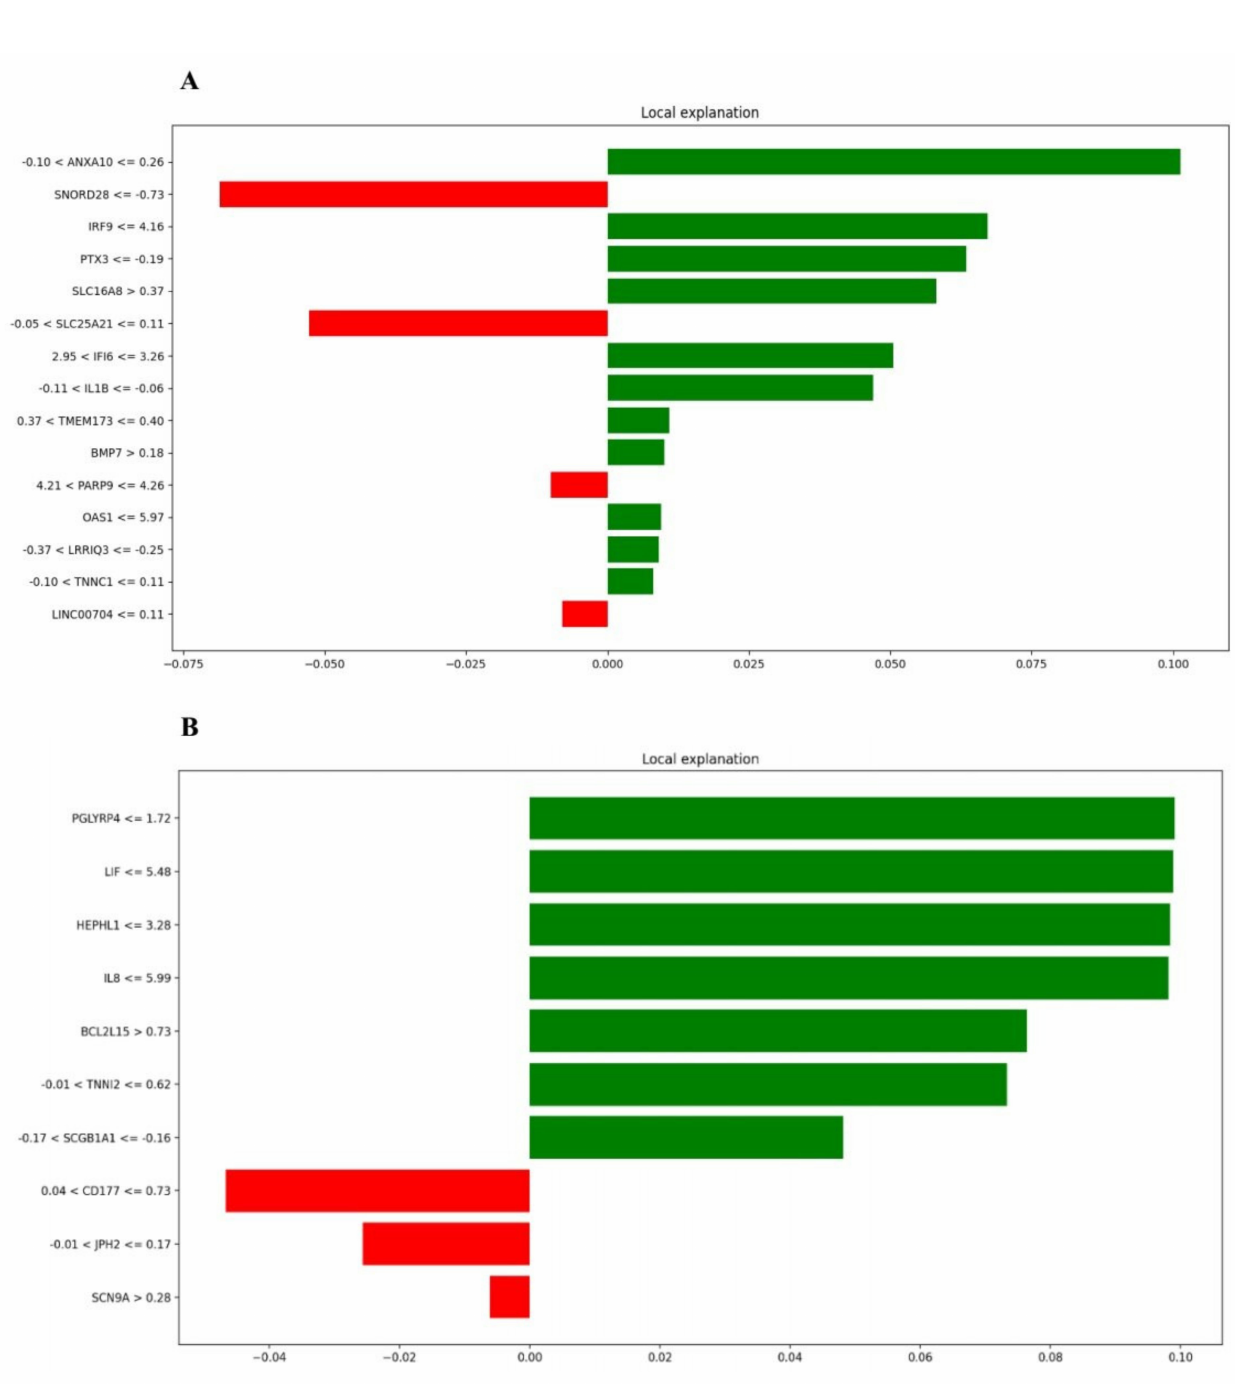
Figure 6. Top genes and their contributions in the model predictions by the SP-LIME algorithm. ( A ) Turquoise module A549 cell line; ( B ) Yellow-green module from NHBE cell